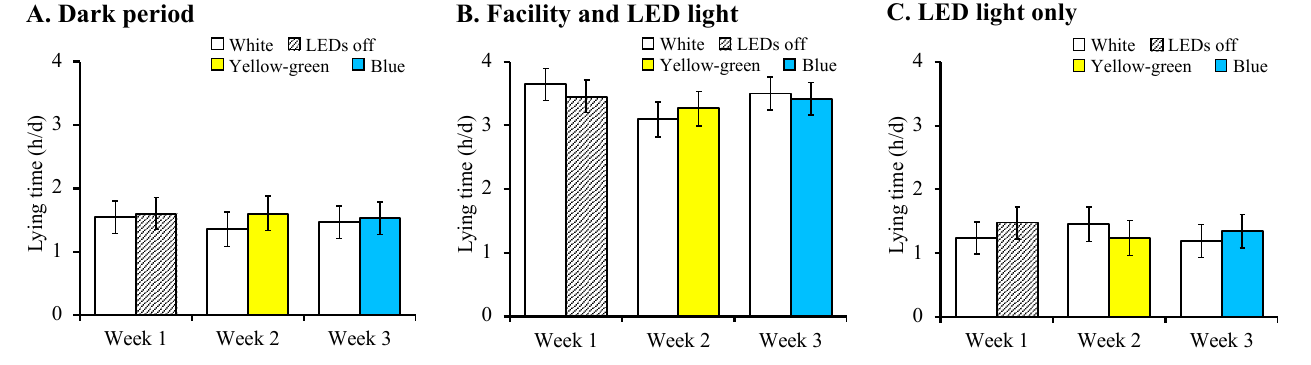
bouts in the supplemental light treatments within weeks.